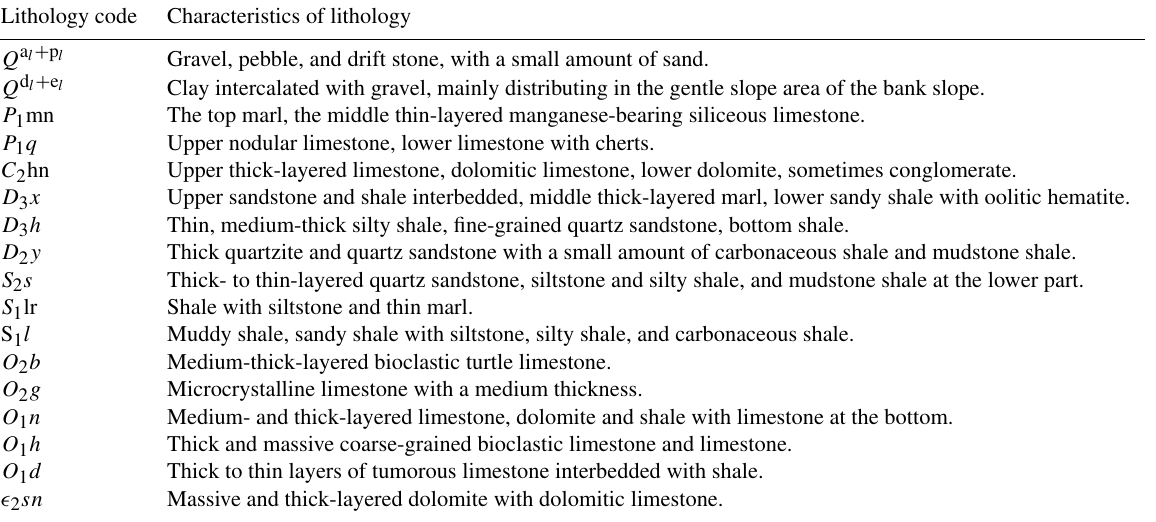
Figure 1. (a) Insert representing Wufeng county hosting the Yuyangguan and neighboring Chengguan community; (b) the distribution of lithological units and recorded landslides in the case community. (The lithology codes in the legend are described in Table 1.) Table 1. Characteristics of lithology distributed among Yuyangguan. Lithology